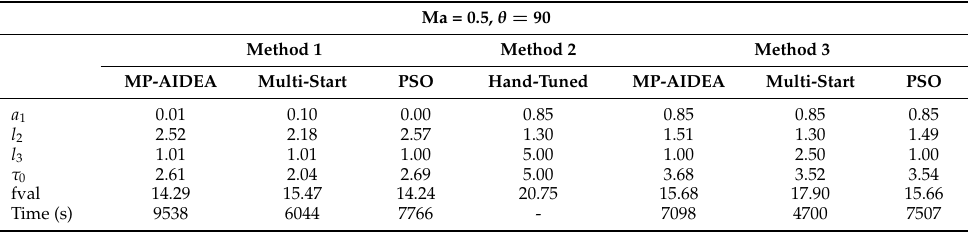
Table 2. Ma = 0.5, θ = 90: Comparison of parameters found from the optimization